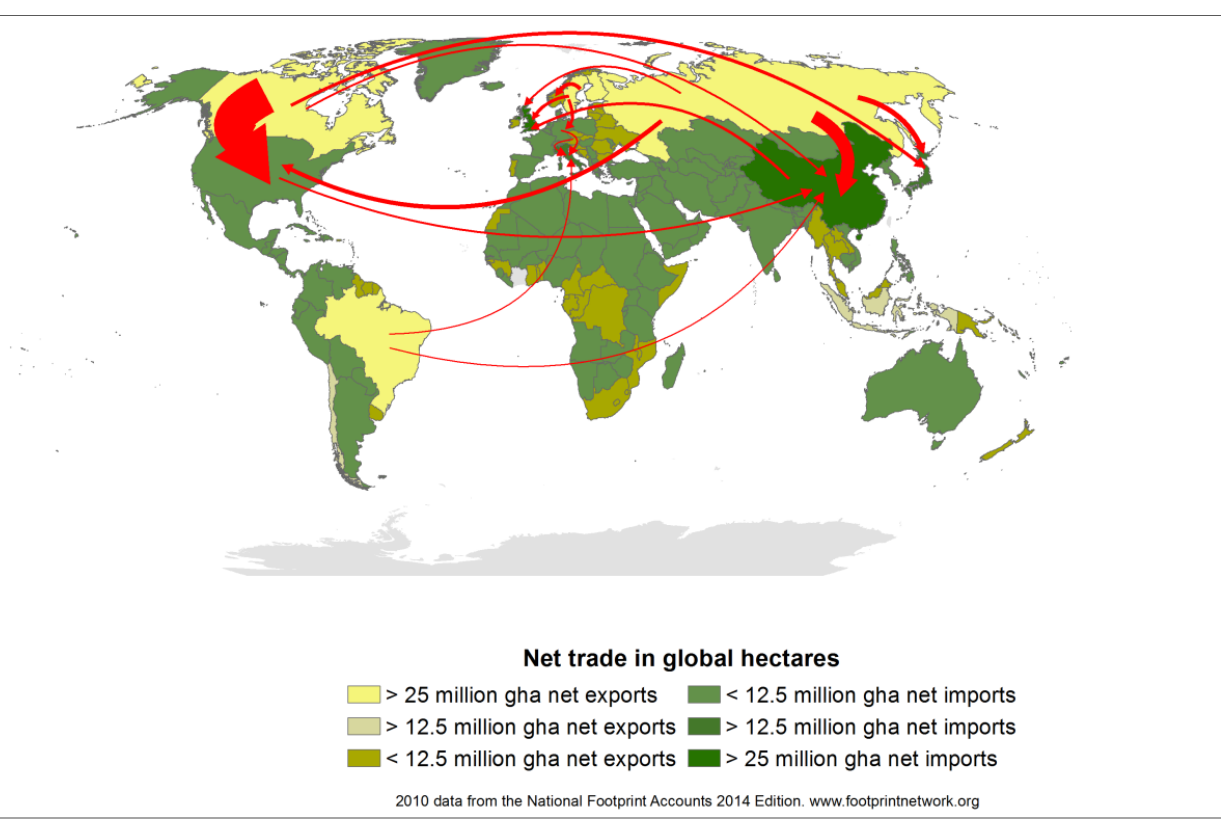
Figure 6. Net trade in forest biocapacity: arrows sized by magnitude of embodied biocapacity show the largest flows into the highest three net importers and out of the highest three net